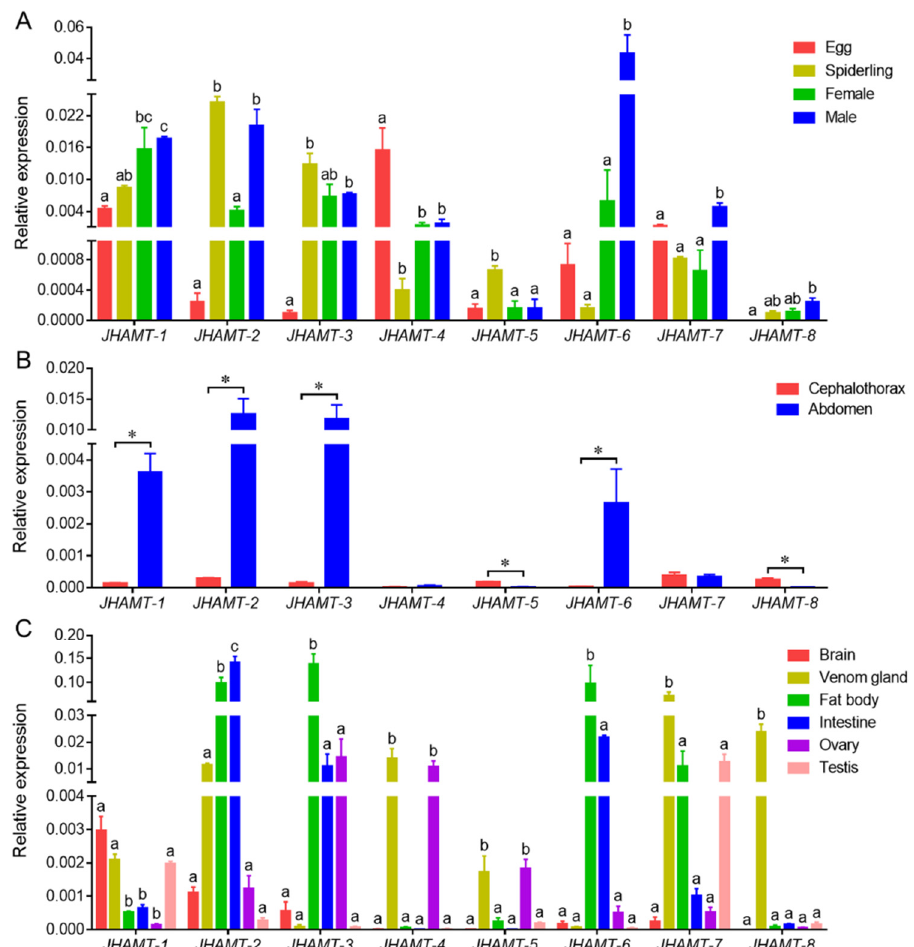
Figure 4. Spatiotemporal expression profiles of eight JHAMT genes in four developmental stages (egg, the second-instar spiderling, adult female, and adult male) ( A ), two parts (cephalothorax and abdomen) from the second-instar spiderlings ( B ), and six tissues (brain, venom gland, fat body, intestine, ovary, and testes) from adult females and males ( C ). Different lower-case letters (a, b, or c) indicated the significant difference of gene expression in four developmental samples and in six tissular samples at p < 0.05. *, p < 0.05.